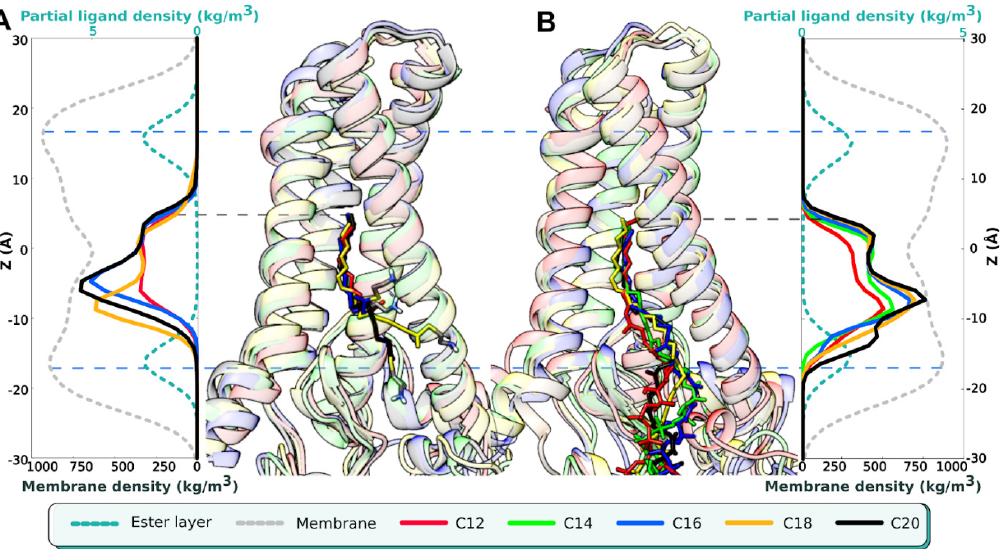
Figure 1. Positioning of the unbound hDHHC20 ligands along the membrane normal (axis Z): acyl- MEA ( A ) and acyl-CoA ( B ). Middle part: aligned conformations from the final MD-snapshots of hDHHC20 with acyl substrates of different length (colored according to the legend). Left and right panels: MD-derived partial density profiles for the respective acyl chain (data for acyl-MEA are taken from [18]). Z = 0 corresponds to the bilayer center. Protein is shown in a ribbon presentation. Lower axis describes the partial POPC density, upper—MEA/CoA acyls. Calculations for ( B ) performed on a set of representative trajectories (Table